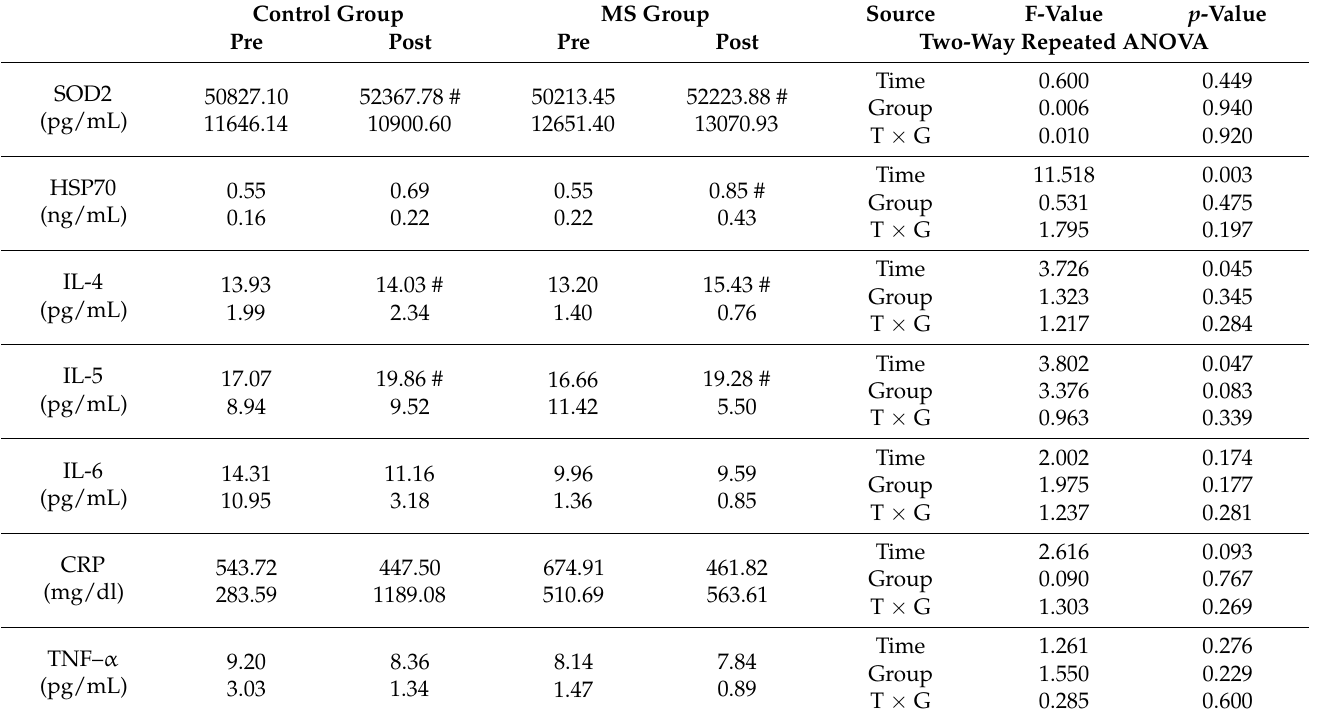
Table 4. Change of anti-oxidants and inflammatory markers after exercise